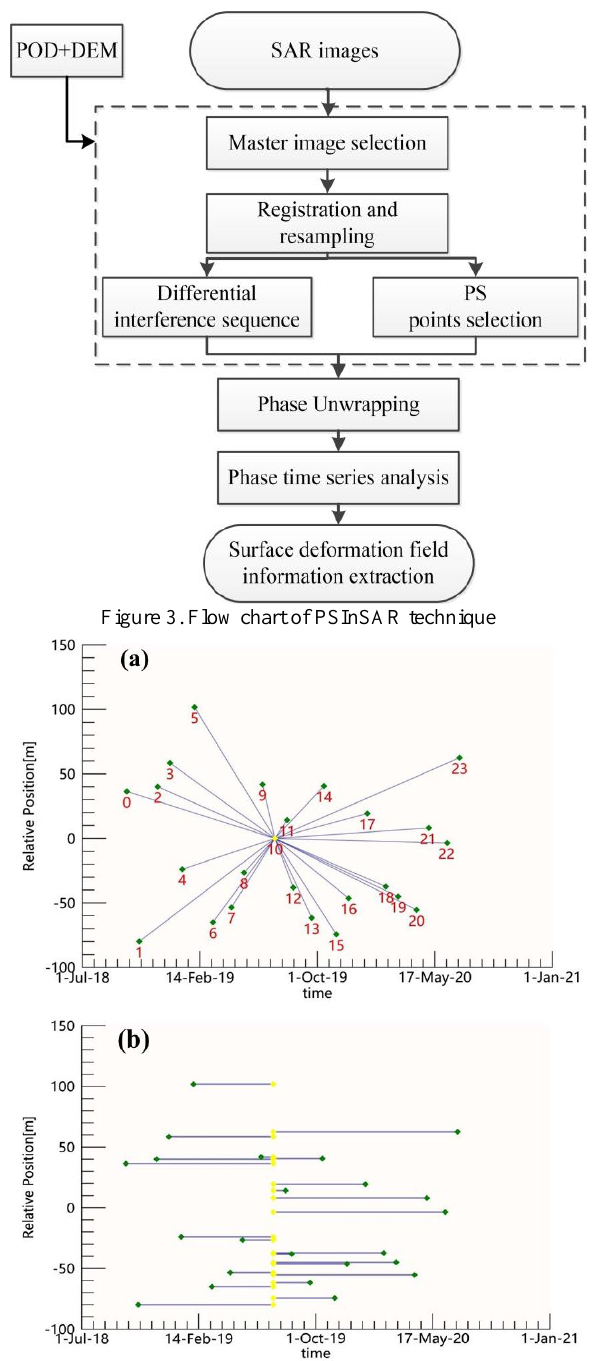
Figure 4. (a) Time-position of Sentinel-1A image interferometric pairs; and (b) time-baseline of image interferometric pairs. The blue lines depict interferometric pairs. The yellow and green diamonds correspond to the master image and secondary images, respectively. (2) The other secondary images are registered with the master